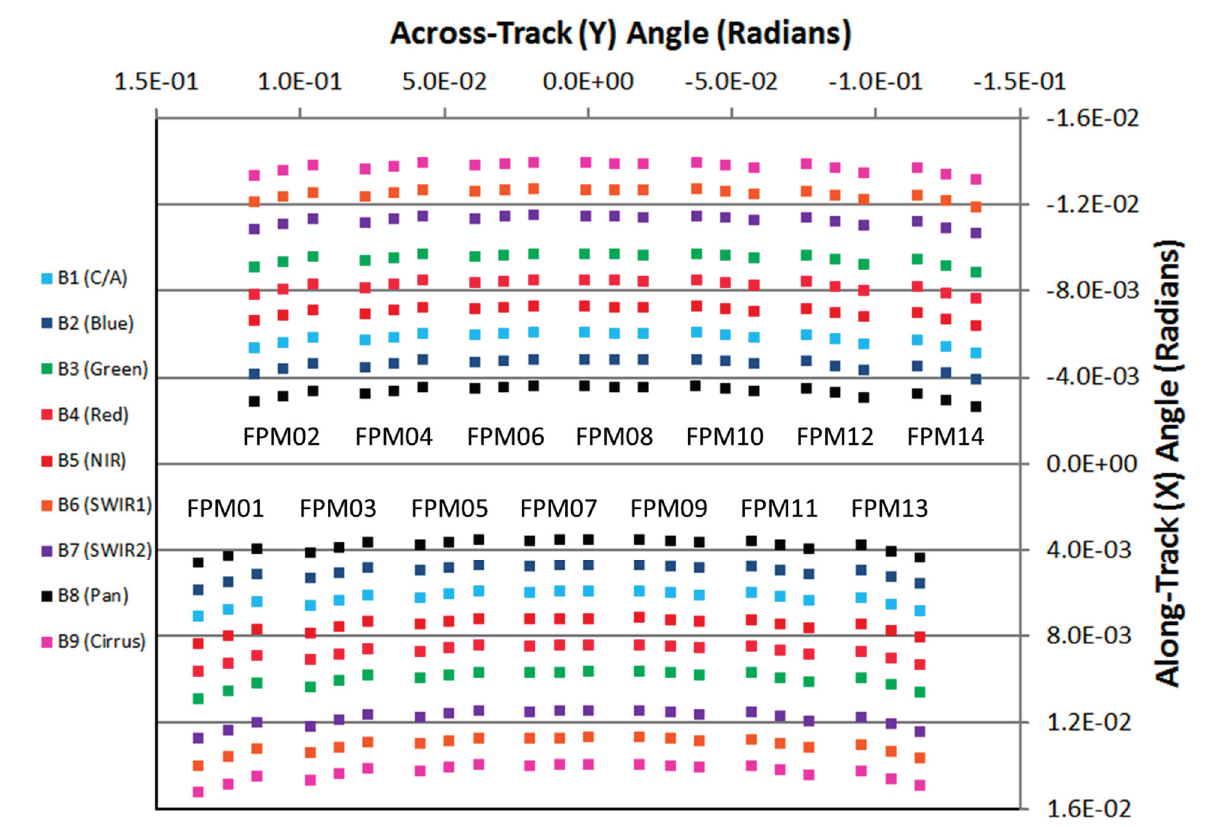
Figure 2. The OLI line-of-sight pattern with the along-track scale, exaggerated by a factor of ~8 to highlight the off-nadir focal plane module (FPM) rotation intended to compensate for optical